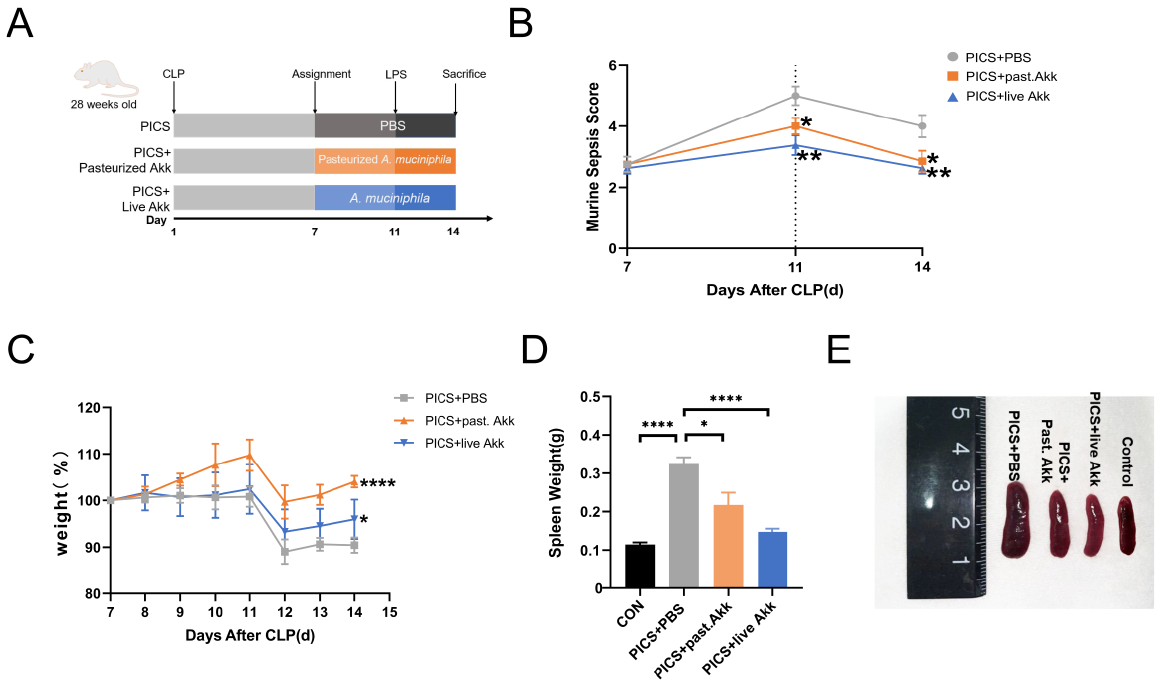
Figure 1. Oral gavage administration of Akk alleviates phenotype in CLP + LPS-induced PICS. ( A ) Establishment of the PICS mouse model and schematic diagram of pasteurized Akk and live Akk treatments. ( B ) MSS calculated with time. ( C ) Body weight changes are expressed as the mean change from the weight on day 7. ( D , E ) Representative spleens of four groups ( E ) and the spleen weight ( D ) were analyzed at day 14. CON = control. past. = pasteurized. MSS = murine sepsis